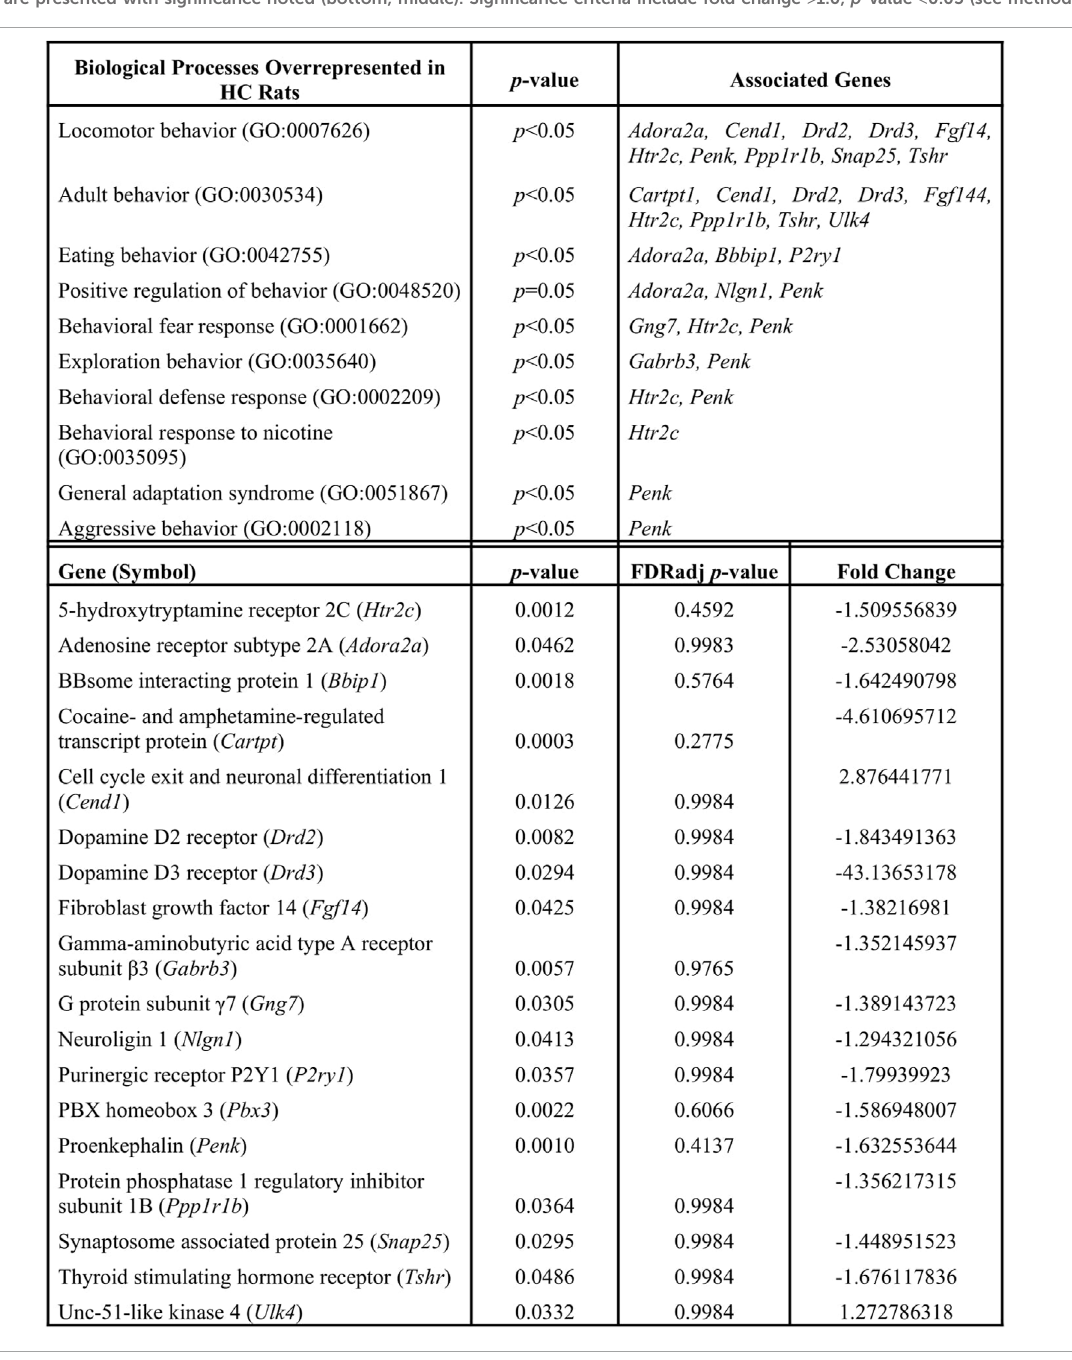
TABLE 1 Functional gene enrichment (IPA plus Cytoscape ClueGO) reveals behavior-related biological processes (top, left) that are overrepresented in the mPFC of HC vs. LC rats, signi fi cance and associated genes noted in upper middle and right columns, respectively. Full gene names